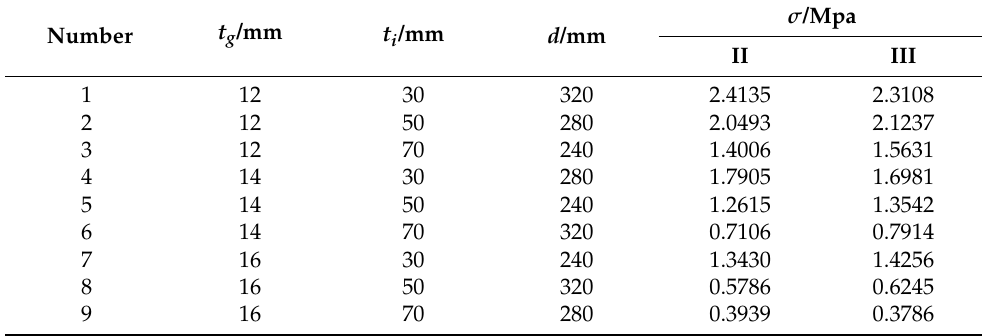
Table 3. L 9 (3 4 ) Orthogonal test data.